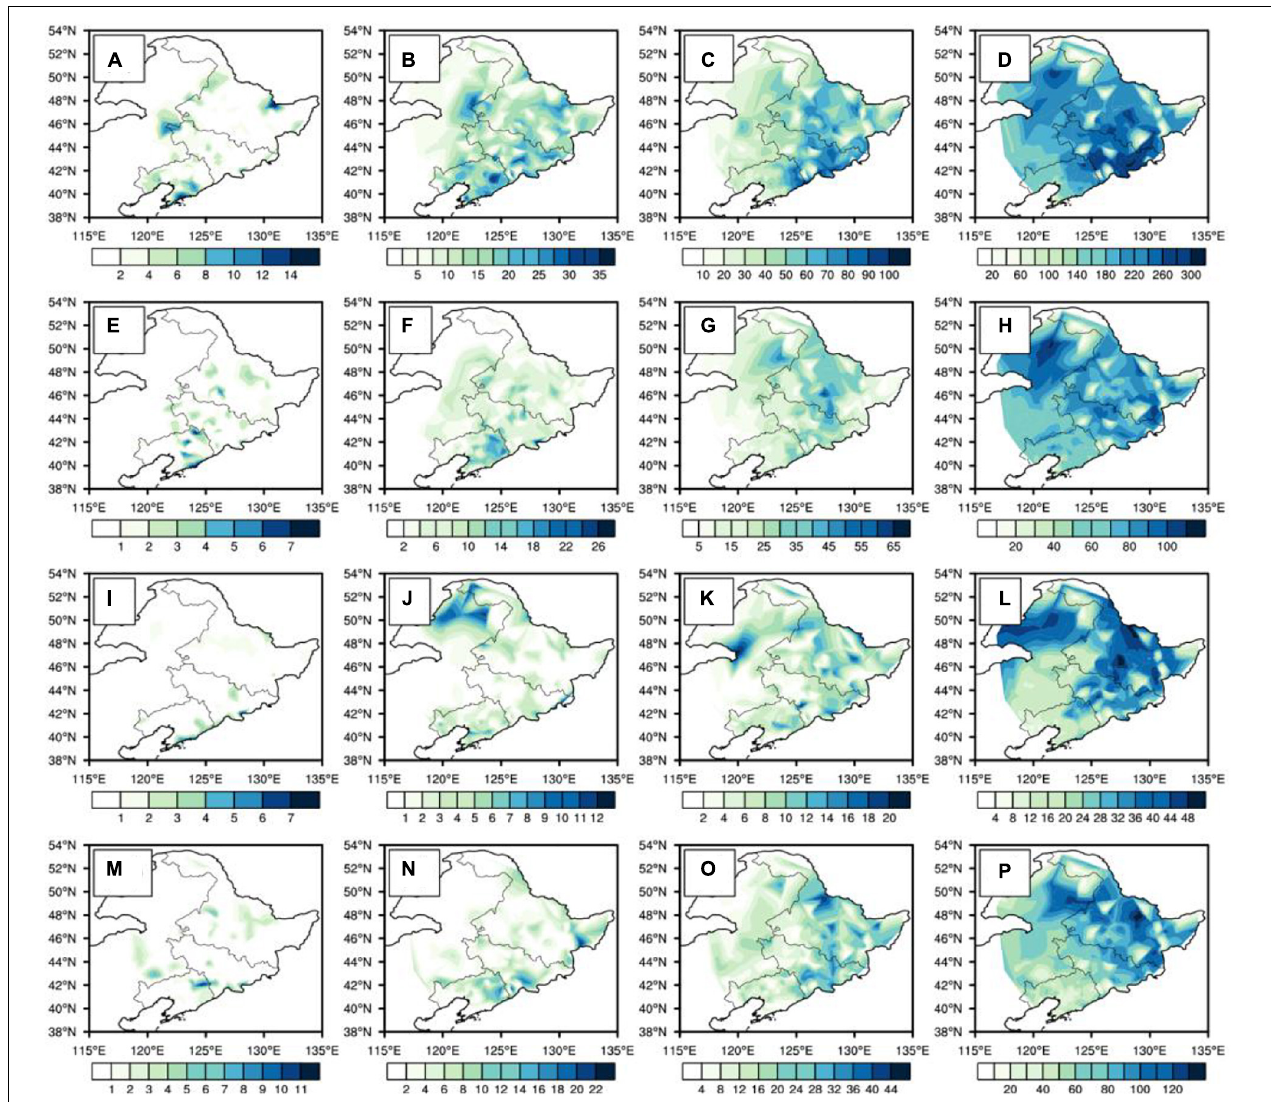
FIGURE 7 | Spatial distribution of the raining days corresponding to various precipitation levels during the NCCV maintaining days ranging from 1979 to 2018 (unit: day): (A,E,I,M) Rainstorms; (B,F,J,M) Heavy rain; (C,G,K,O) Moderate rain; (D,H,L,P) Light rain.